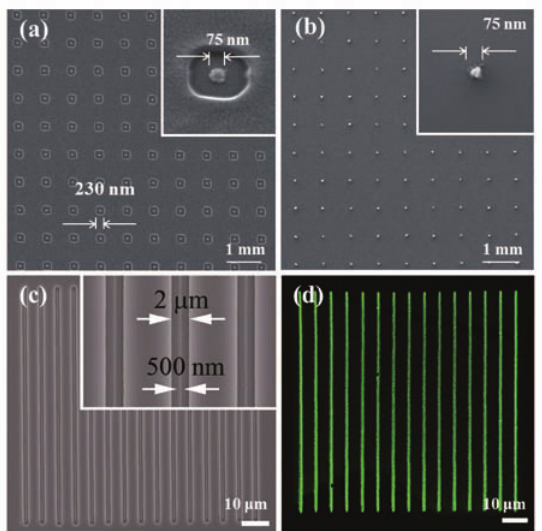
Fig. 4 (a) A SEM image of 75-nm dot arrays of 10-nm Ag particles formed within 230-nm PR